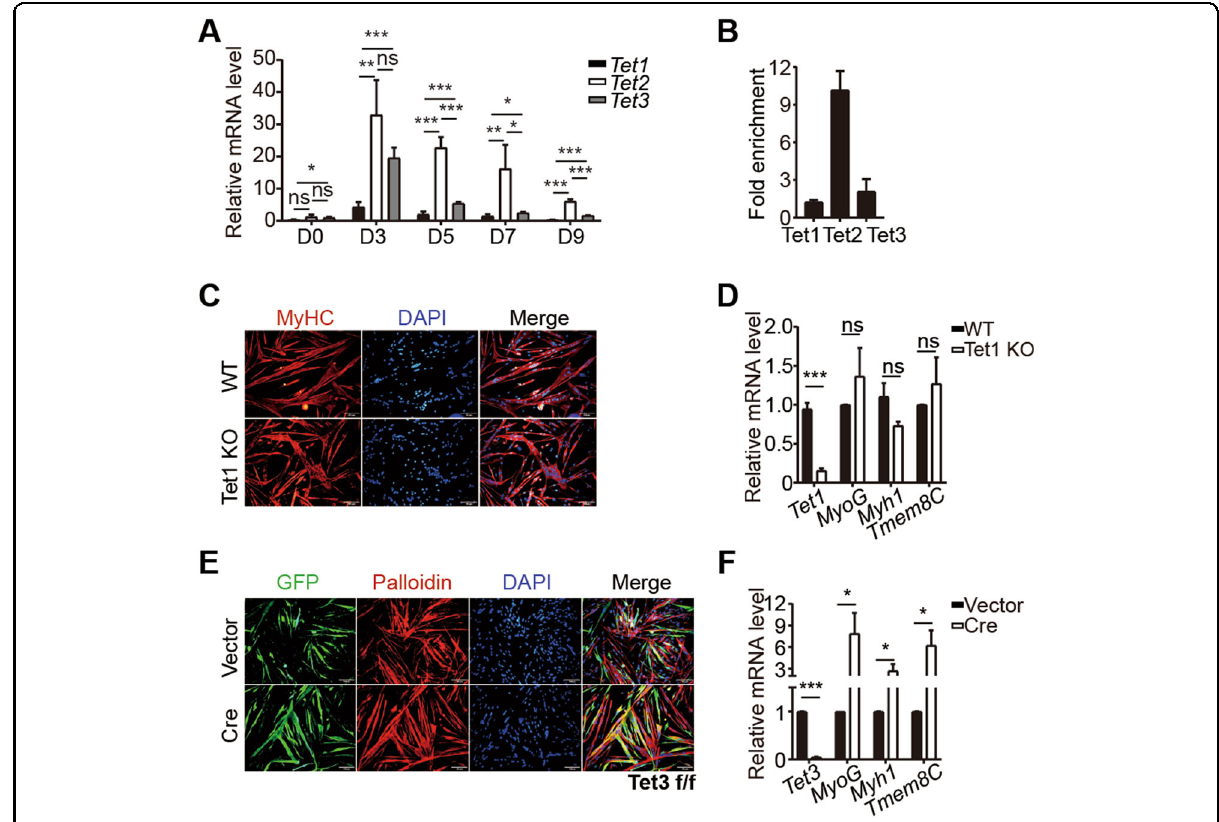
Fig. 7 Tet2, but not Tet1 and Tet3, speci fi cally promotes myogenesis. A The relative expression levels of Tet1 , Tet2 , and Tet3 during muscle regeneration ( n = 3). B Tet2 recruitment on E2 enhancer ( n = 3). Myoblasts were isolated from Tet1-HA, Tet2-HA, Tet3-HA mice, respectively. ChIP- qPCR assays were performed using anti-HA. C Immuno fl uorescence staining of MyHC in Tet1 KO myotubes. Scale bars, 100 µm. D Relative mRNA expression level of Tet1 , MyoG , Myh1 , Tmem8C in Tet1 KO myoblasts ( n = 3). E Immuno fl uorescence staining of GFP and Phalloidin in Tet3 KO myotubes. Scale bars, 100 µm. F Relative mRNA expression level of Tet3 , MyoG , Myh1 , Tmem8C in Tet3 KO myoblasts ( n = 3). * p < 0.05, ** p < 0.01, *** p <